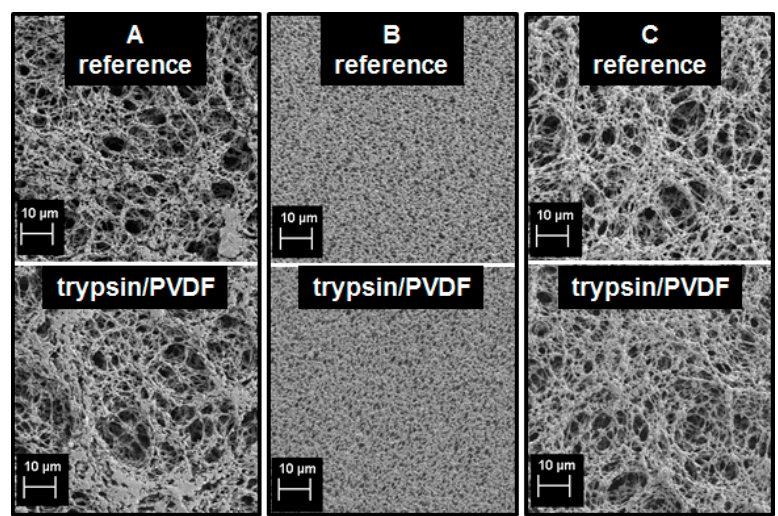
Figure 4. SEM images of membranes A , B , and C prior (reference) and after modification (trypsin/PVDF).